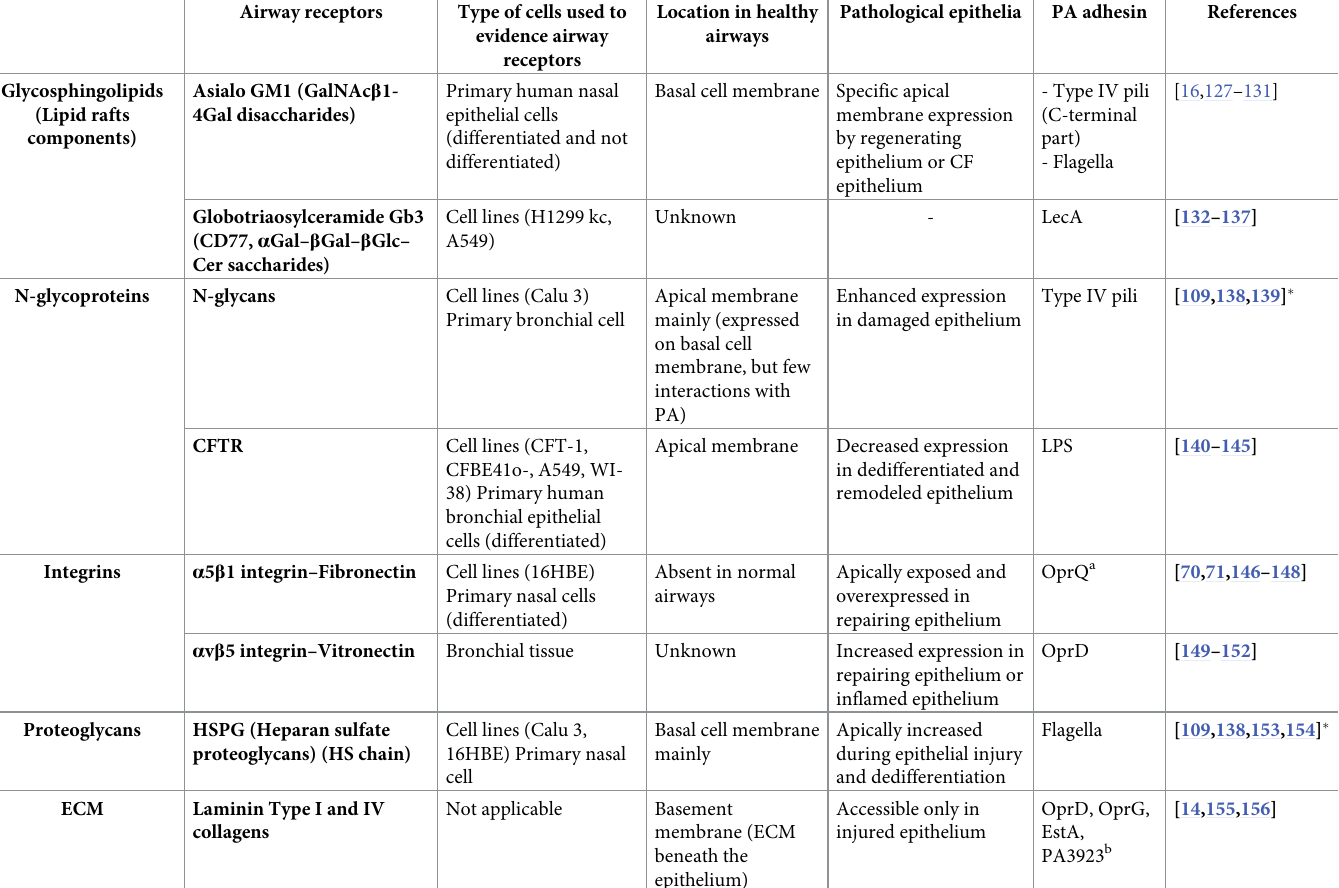
Table 1. P . aeruginosa airway